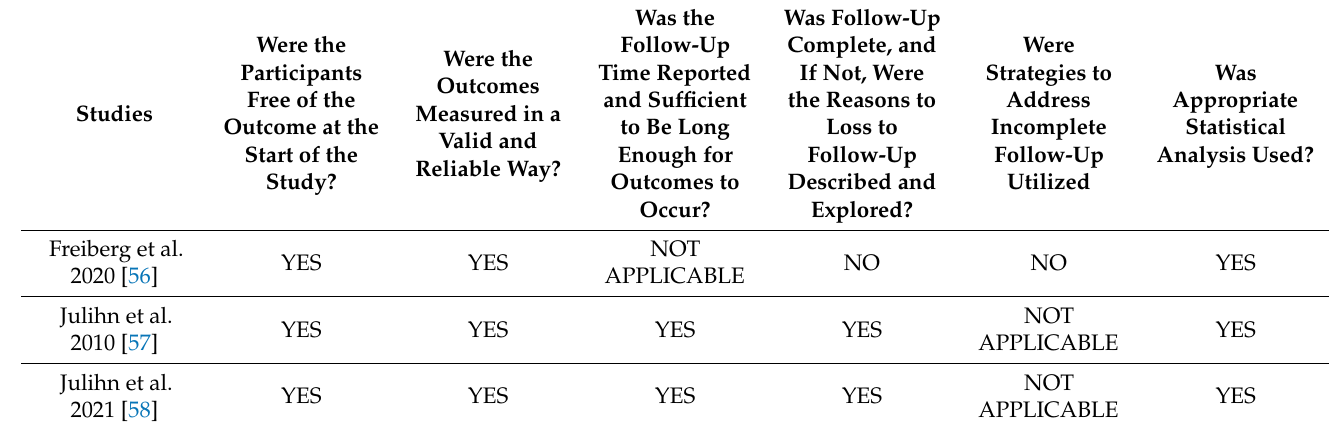
Table 4. JBI for cohort studies: outcome, follow-up, statistical